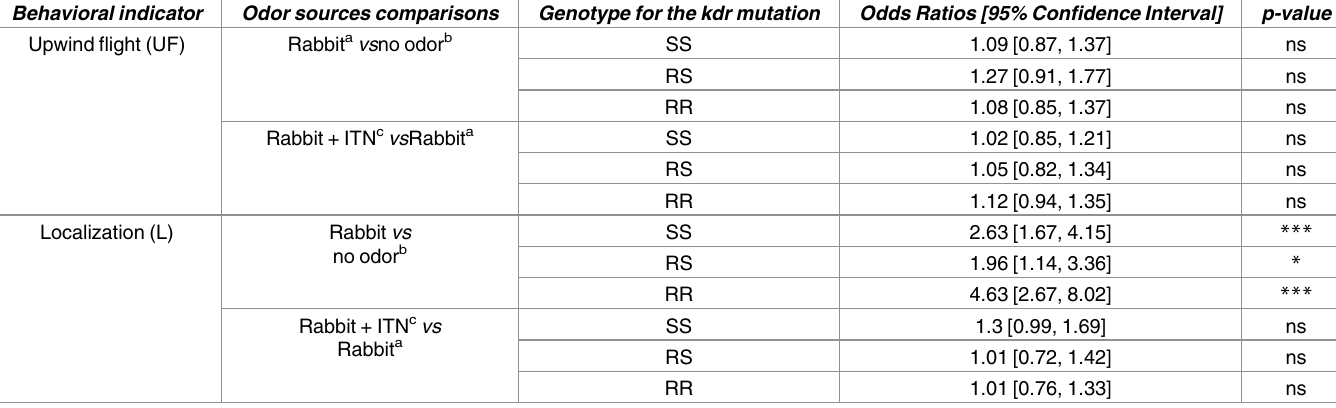
Table 3. Results of the upwind flight (UF) and localization (L) generalized linear